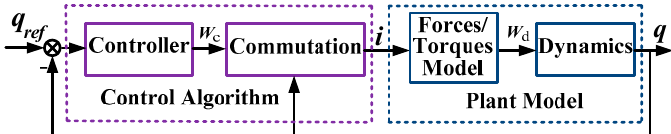
Figure 1. Basic control structure including the commutation (algorithm) of coil array and the electromagnetic forces/torques model Different commutation methods will result in different distributions of currents and ohmic